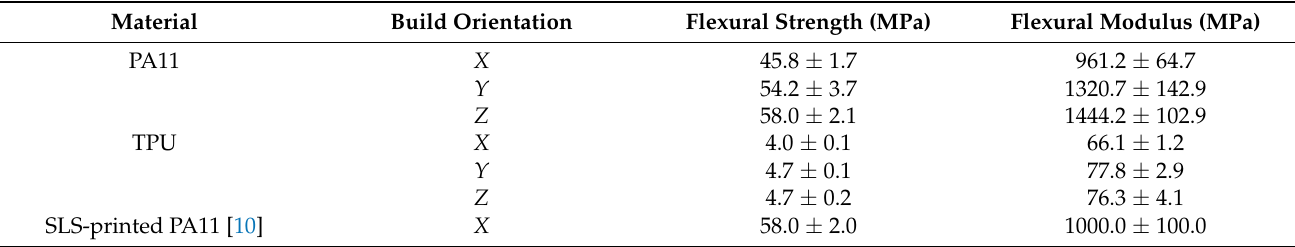
Table 6. Flexural properties of the PA11 and TPU